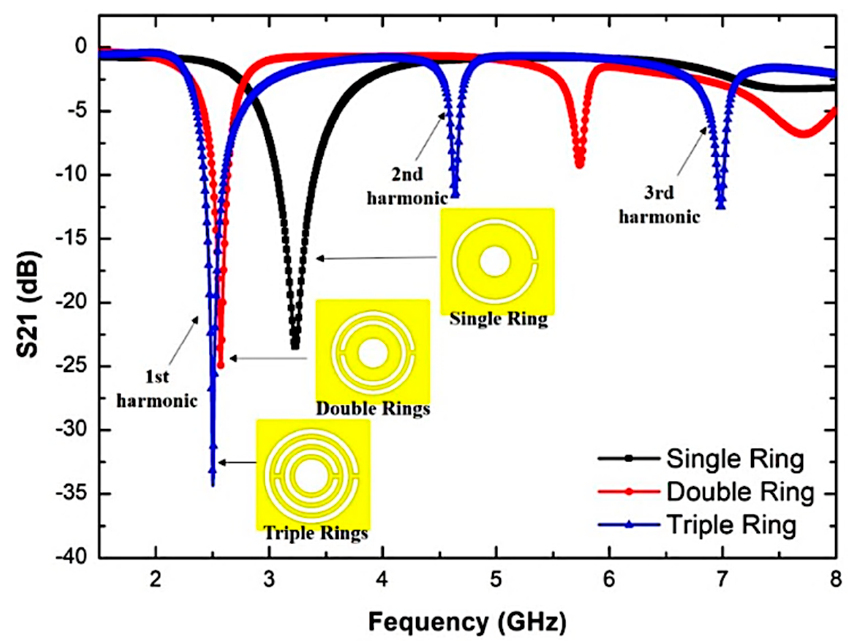
Figure 5. Simulated insertion loss characteristics of a single, double and triple-rings CSRR sensor.